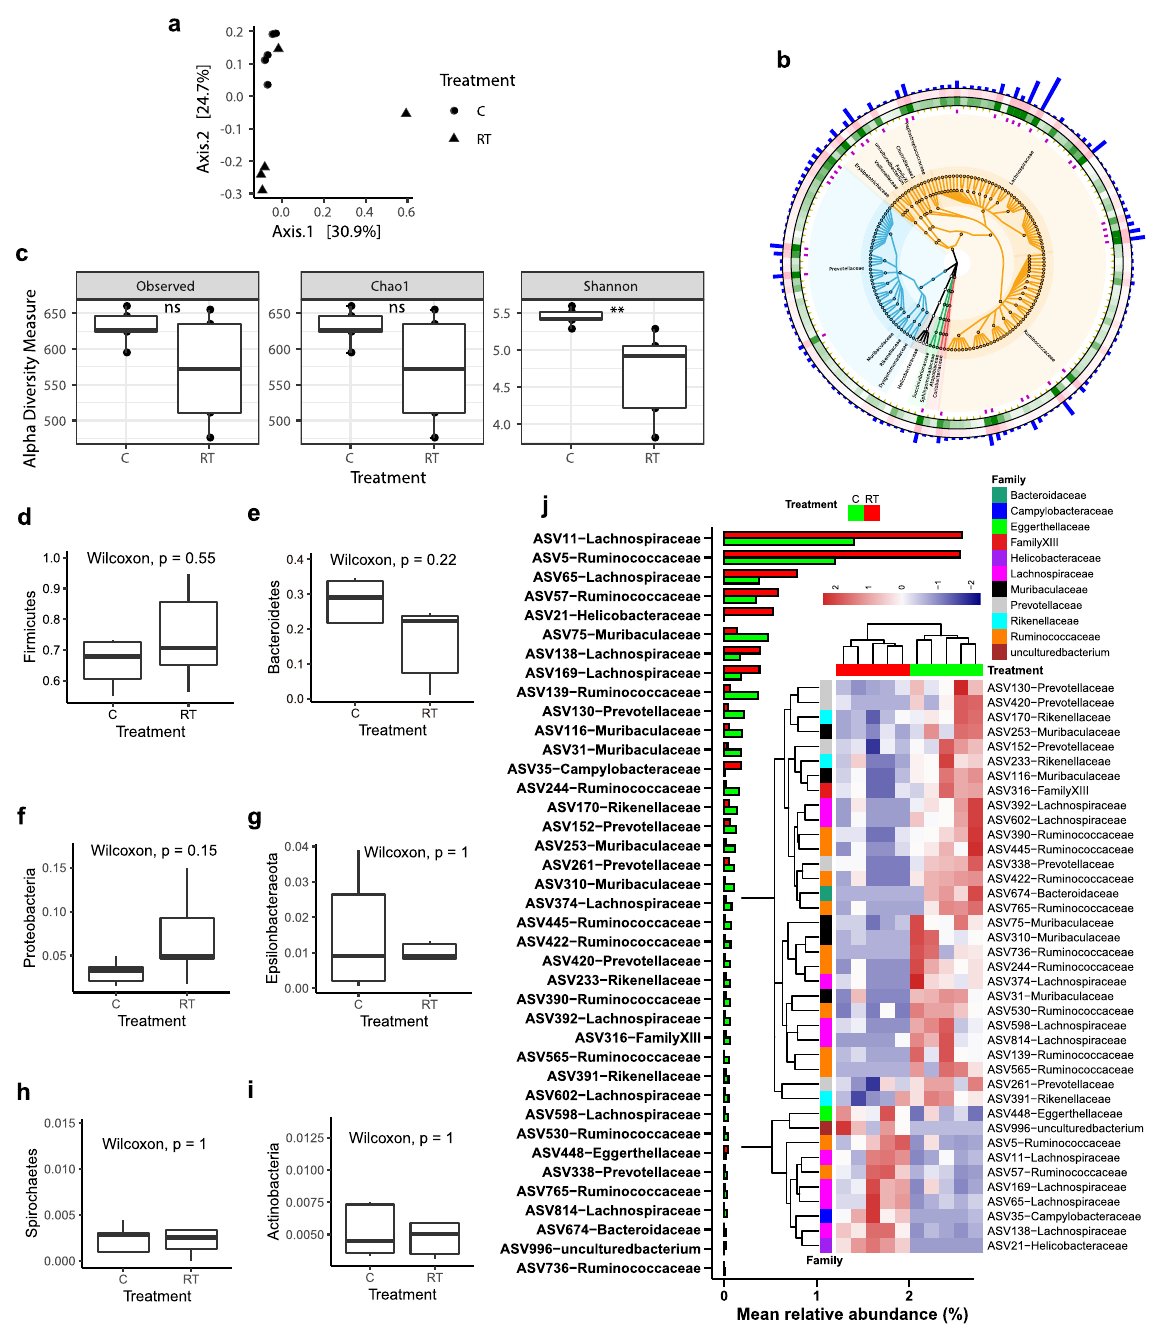
Fig. 3 Cold exposure changes the cecal microbiota composition. a Principal coordinates analysis (PCoA) based on the weighted UniFrac distances. Each symbol represents a single sample of the cecal content after 48 h of cold exposure ( n = 5) or RT controls ( n = 5 per group). b Heatmap tree comparing the most abundant ASVs from the cecum content of 48 h cold-exposed animals ( n = 5, inner green rings) and RT controls ( n = 5, outer pink rings) and their phylogenetic relationships. The bar represents abundant ASVs. Firmicutes and Bacteroidetes appear in orange and blue colors, respectively. c The alpha diversity of ASVs. d – i Boxplot of the microbiota of the cecal contents at the phylum level. j The different ASVs with a bar and heatmap with P < 0.05. The data are the means ± SEMs ( n = 5 per